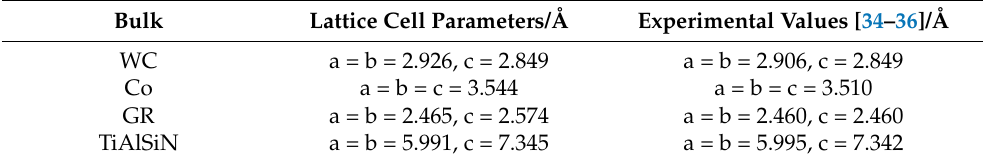
Table 1. The lattice cell parameters of WC, Co, GR, and TiAlSiN.